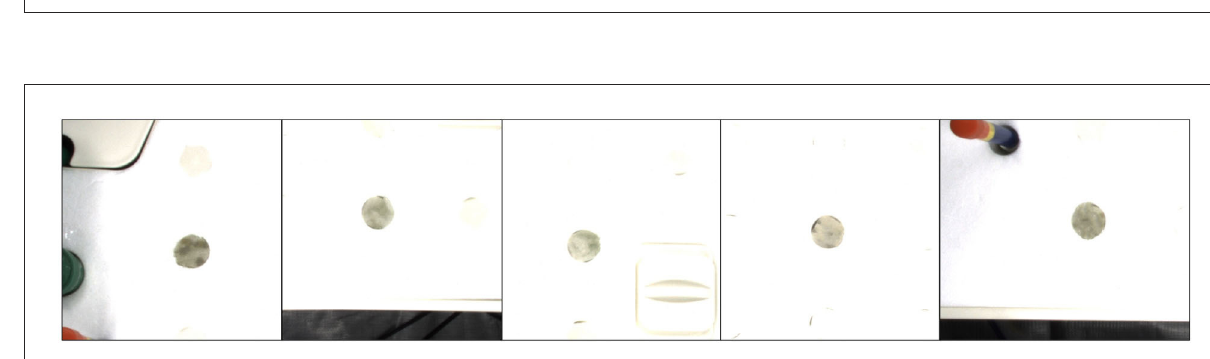
FIGURE5 Examples of clean background images, extracted from the plants in the KOMATSUNA